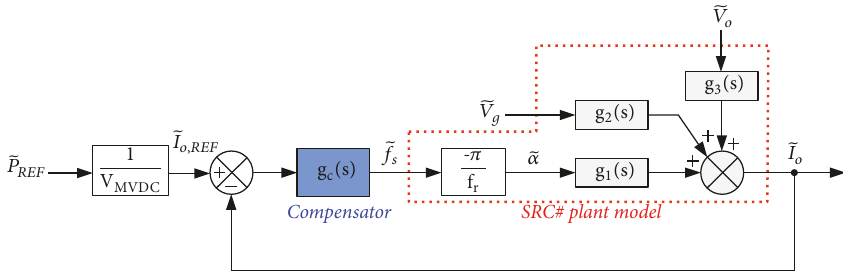
Figure 7: Small-signal control model of the series resonant converter SRC# in subresonant